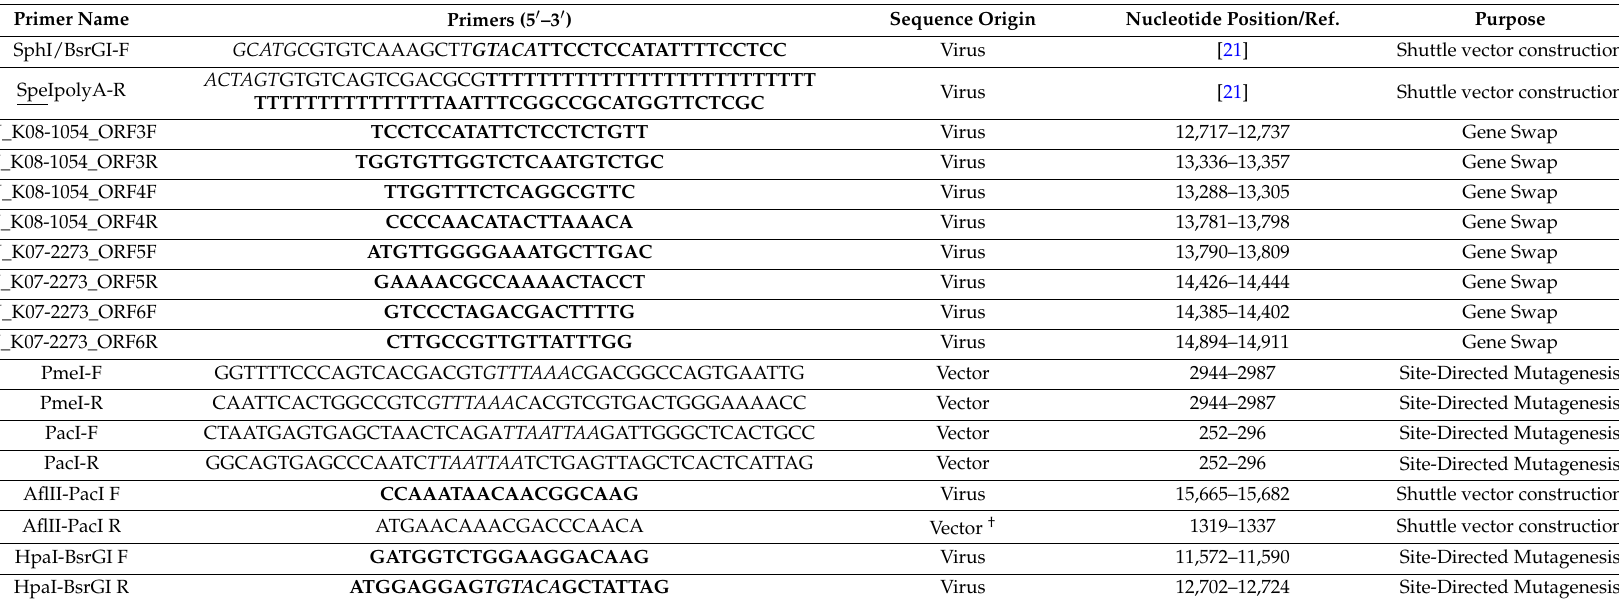
Table 2. Primers used in the construction of the chimeric